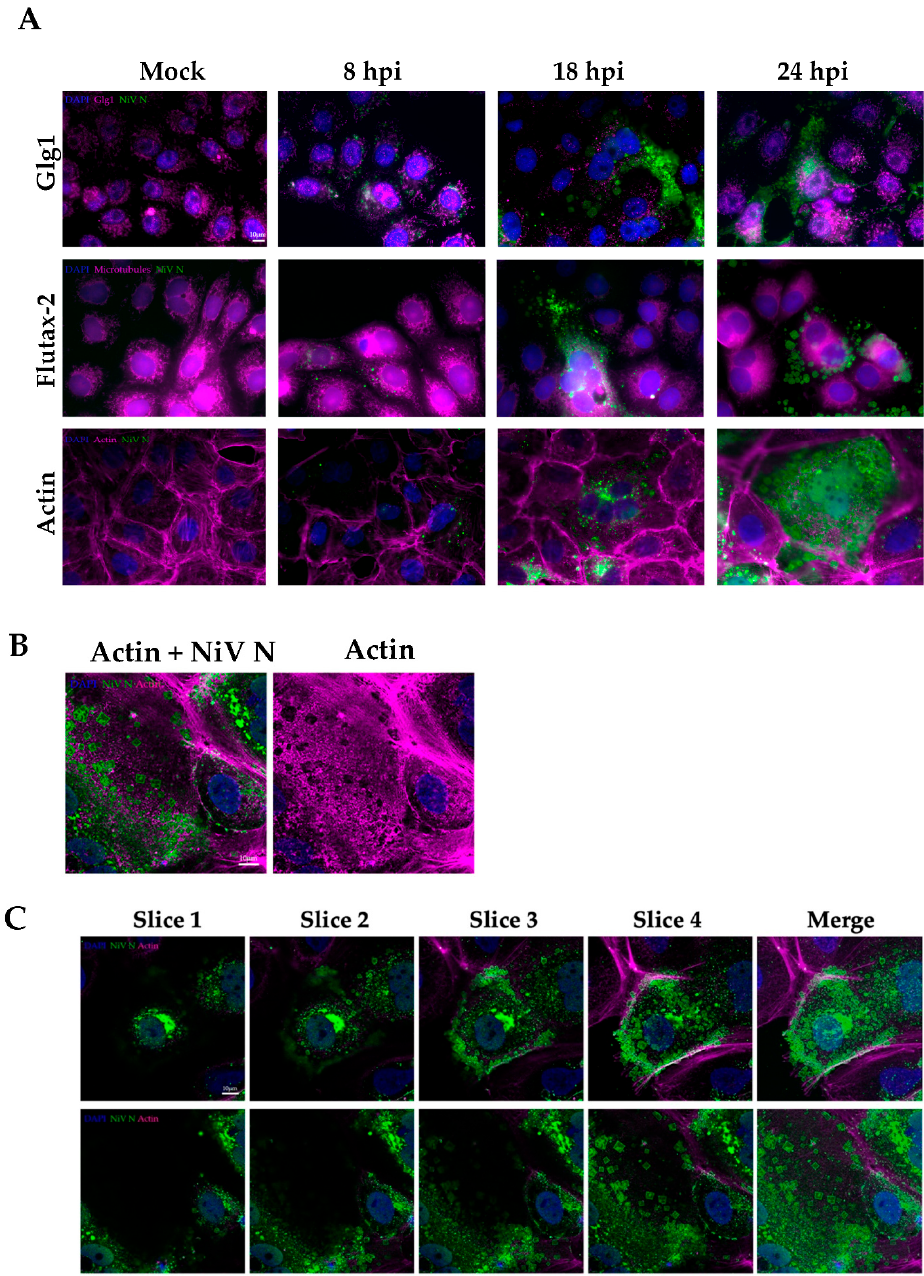
Figure 3. Kinetics of the formation of ordered structures and lack of colocalization of NiV N in different cellular structures. ( A ) Vero E6 cells were fixed at 8, 18, and 24 h post infection (hpi), and relative localization of Golgi (Glg1, magenta), microtubules (Flutax-2, magenta) and actin (Phalloidin, magenta), together with NiV N (green) are shown. Cellular nuclei are stained with DAPI (blue); scale bar: 10 µm. ( B ) Vero E6 staining with NiV N (green) and actin (Phalloidin, magenta); scale bar: 10 µm. ( C ) Z-slices of a z-stack from Vero E6 cells stained with NiV N (green) and actin (Phalloidin, magenta); scale bar: 10 µm.